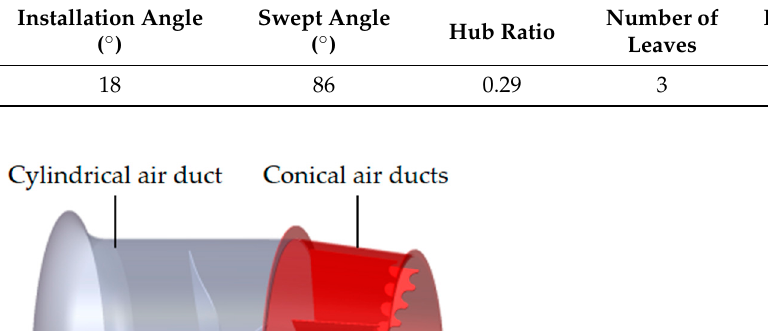
Table 1. Basic parameters of circular arc plate blade.